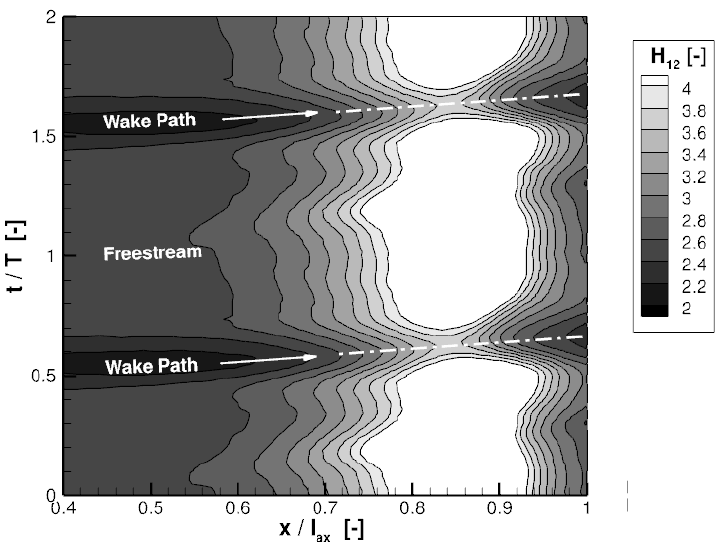
Figure 6. Space-Time diagram of shape factor H 12 predicted by the time-integration